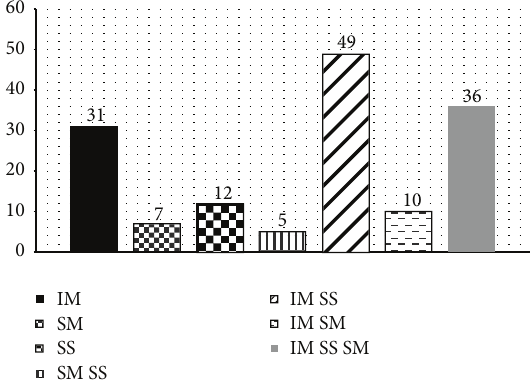
Figure 2: Leiomyomatous nodules distribution found in women fromPernambucointheperiodfrom2001to2002accordingtotheir anatomical location: intramural (IM), submucosal (SM), subserosal (SS), submucosal and subserosal (SM SS), intramural and subserosal (IM SS), intramural and submucosal (IM SM), and intramural, subserosal, and submucosal (IM SS SM).